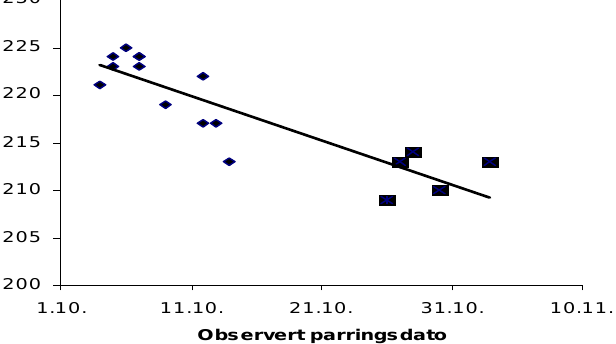
Fig. 4. Sammenhengen mellom observert parringsdato og drektighetslengde i 2003 for simler i første ( (cid:1) ) og andre ovulering ( (cid:2) ) (Holand et al .,